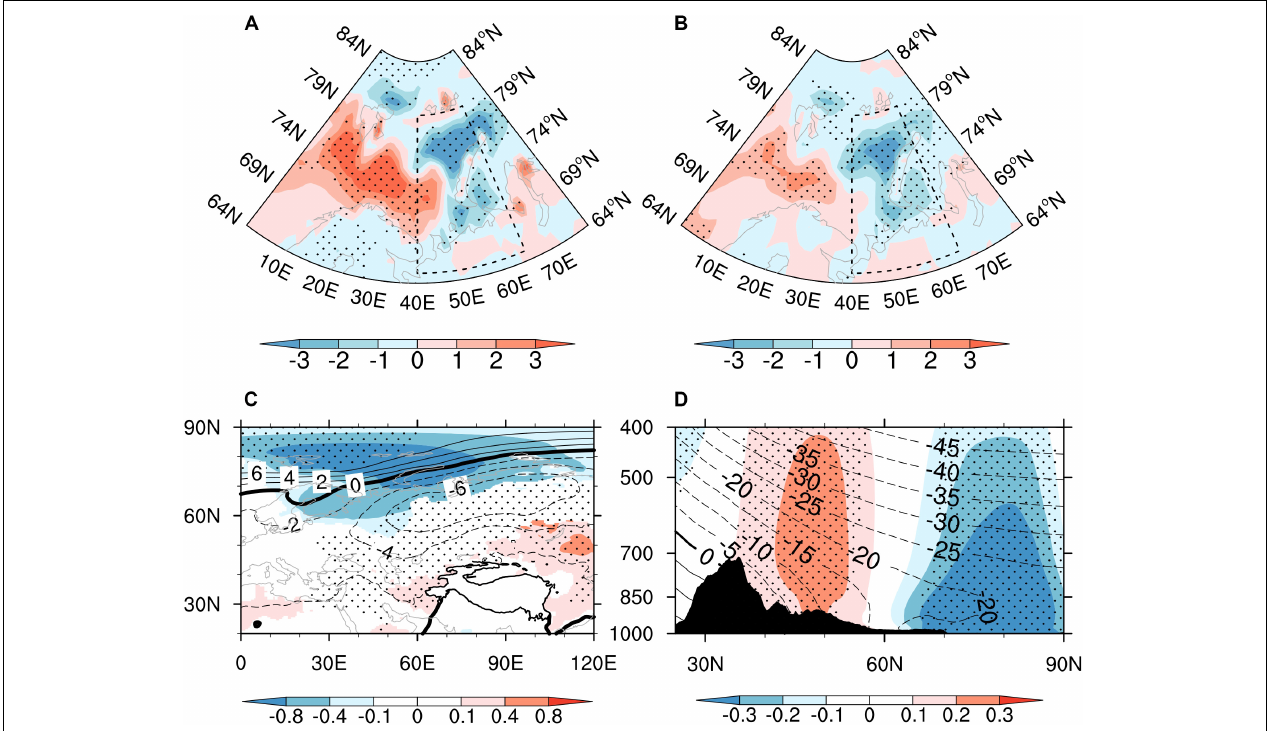
FIGURE 3 | Regression fields of (A) the winter surface sensible heat flux (units: W/m 2 ), (B) the winter surface latent heat flux (units: W/m 2 ), (C) the 1000-hPa air temperature (shaded; units: ◦ C) and surface pressure (contours; units: Pa), and (D) the 50 ◦ –120 ◦ E-averaged air temperature (shaded; units: ◦ C; contours are the climate mean air temperature) against the BSICI. The shading and contour values of the stippled areas in A, B, D, and C exceed the p = 0.1 confidence level. The shaded values in C exceed the p = 0.1 confidence level. The dashed box in A and B denotes the Barents Sea region (65 ◦ –80 ◦ N, 35 ◦ –65 ◦ E). The black line over the region (25 ◦ –45 ◦ N, 60 ◦ –110 ◦ E) in C outlines the 2-km topography of the Tibetan